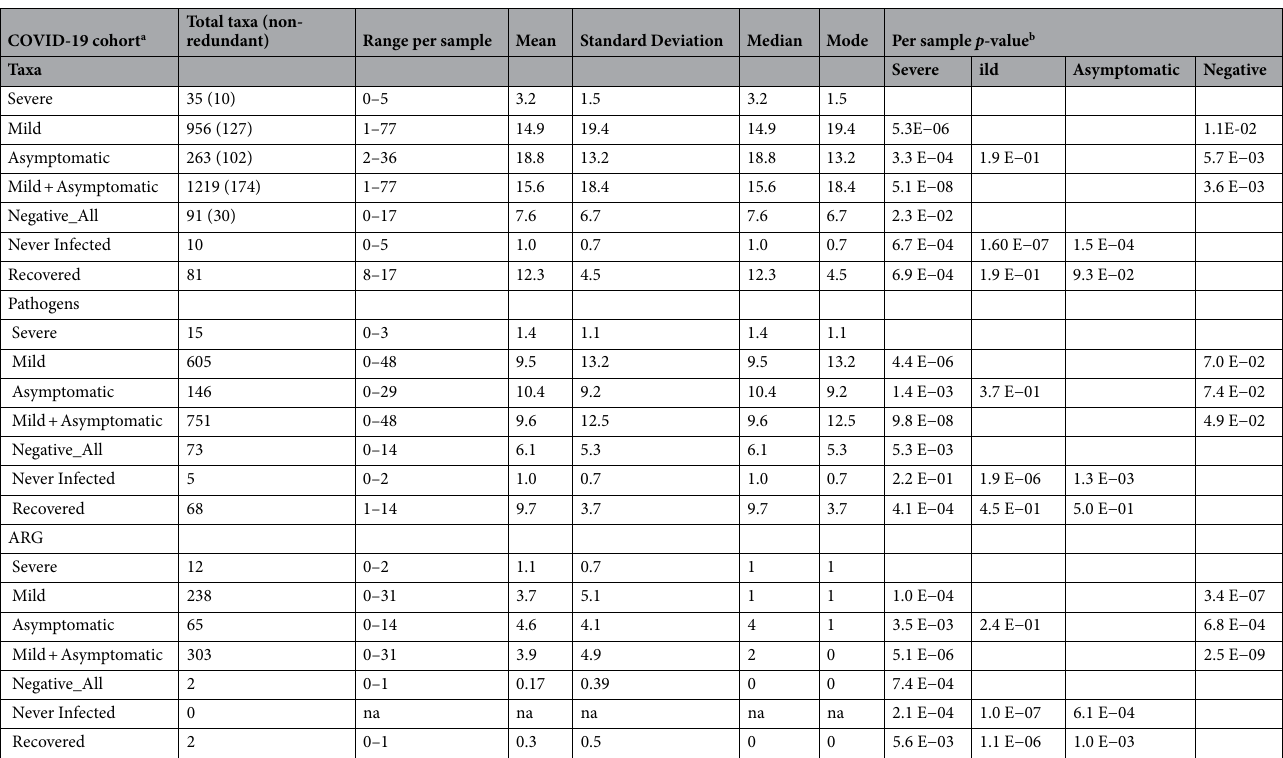
Table 1. Carriage of taxa, pathogens and ARG in COVID-19 cohorts. Severe, n = 11; Mild, n = 64; Asymptomatic, n = 14; Negative_All, n = 12; Never Infected, n = 5; Recovered, n = 7. Bold text, not significant; Welch’s t test, unequal variances; na, not